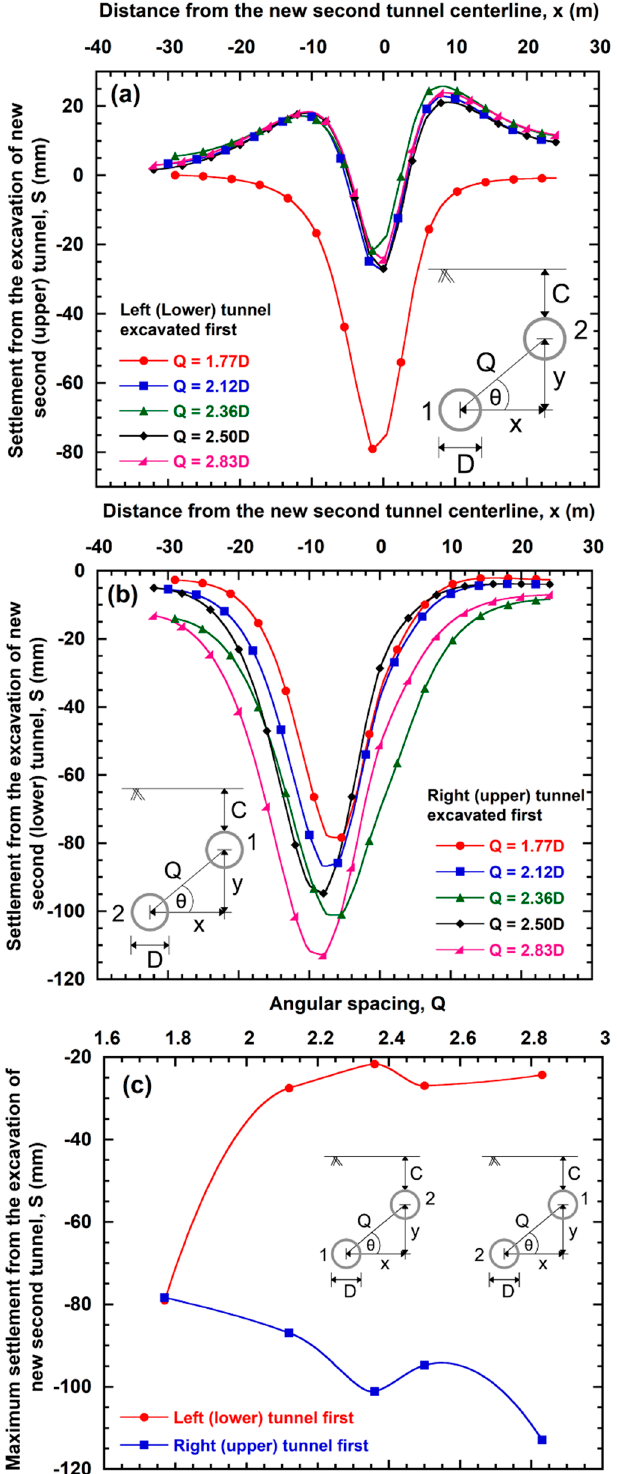
Figure 11. Effect of angular spacing on ( a , b ) surface settlement above the new second tunnel and ( c ) maximum settlement from the excavation of the new second tunnel.